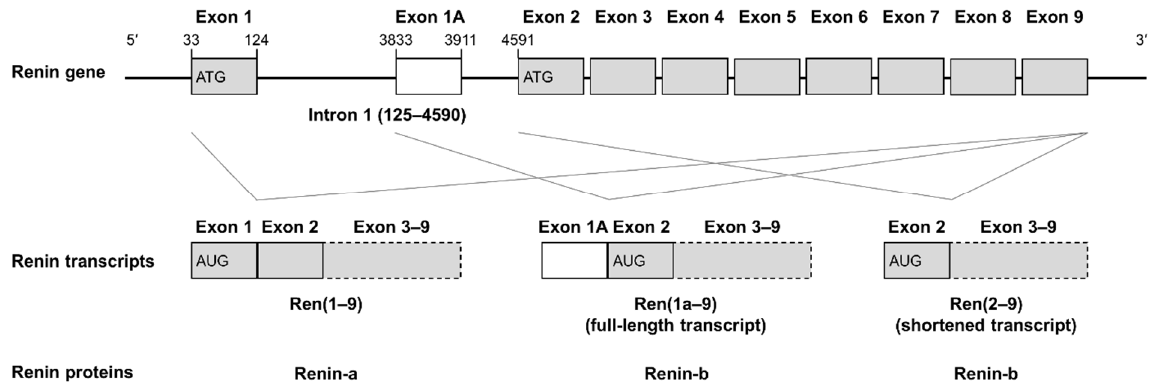
Figure 1. Structure of the rat renin gene and transcripts encoding two different renin proteins. The renin gene comprises 9 exons (gray boxes), where an alternative exon 1 named exon 1A (white box) is located within intron 1. Transcription leads to three transcript variants comprising Ren(1–9), including the classical exon 1 as well as the alternative transcripts Ren(1a–9) and Ren(2–9) , where Ren(1a–9) comprises the 5 ′ UTR located in exon 1a and Ren(2–9) is missing it. The transcription of Ren(1–9) starts at AUG in exon 1, while for Ren(1a–9) and Ren(2–9), the start codon is located in exon